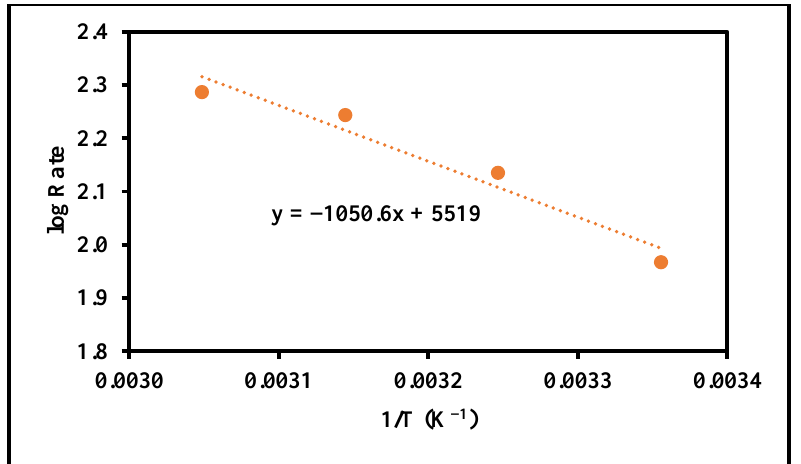
Figure 5. Determination of the activation energy.